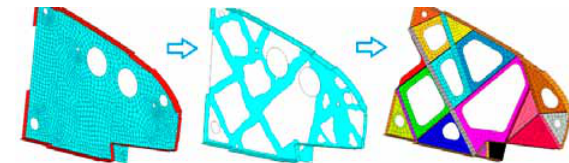
Fig. 5. An example of a topology optimized wing rib structure of an Airbus A380 aircraft